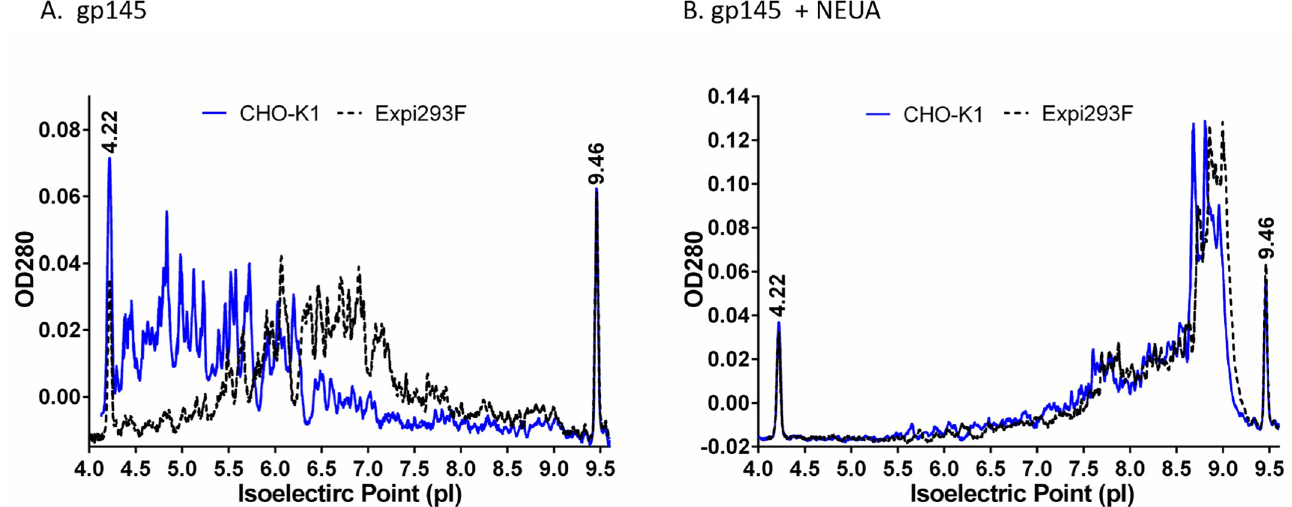
Fig 5. The impact of sialylation on HIV-1 gp145 isoelectric point. Electropherograms from 3 consecutive injections of CHO-K1- (blue lines) and Expi293F- produced (black dash lines) gp145 with ( B ) and without ( A ) neuraminidase. The prefocusing was performed for 1 min at 1.5 kV and the focusing for 3.0 kV at 4.5 min. Capillary IEF sample solutions contained 0.7 μ g/ μ L of gp145, 5 M urea, pI markers 4.22/9.46 and servalyte 2–9 carrier ampholytes.